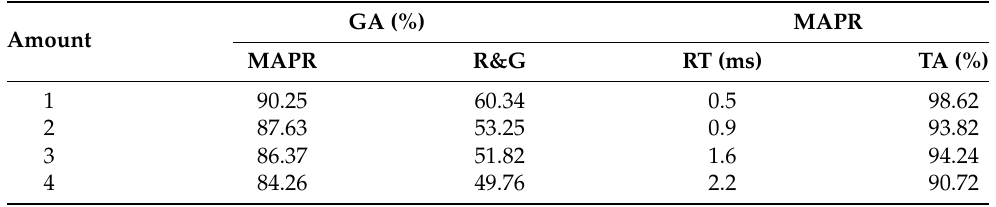
Table 2. Comparative simulation results